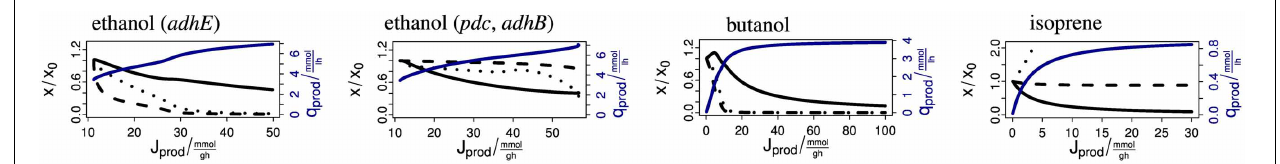
FIGURE 6 | Steady-state response of the model to enforced biofuel production. The abscissas shows the biomass-specific production flux in mmol/g/h. The black solid lines show the biomass. The dashed and dotted lines show the intracellular concentration of the relevant redox and carbon